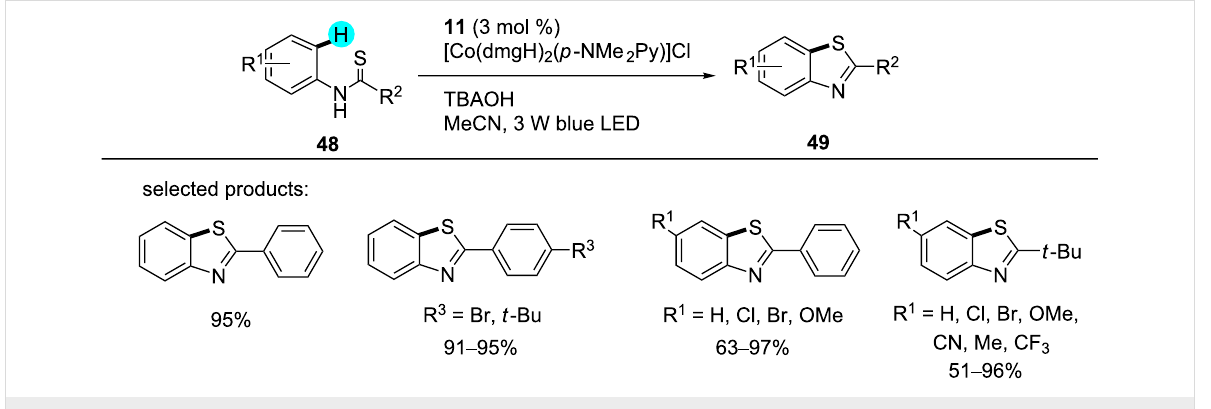
Scheme 6: Synthesis of benzothiazoles via oxidant-free C–H